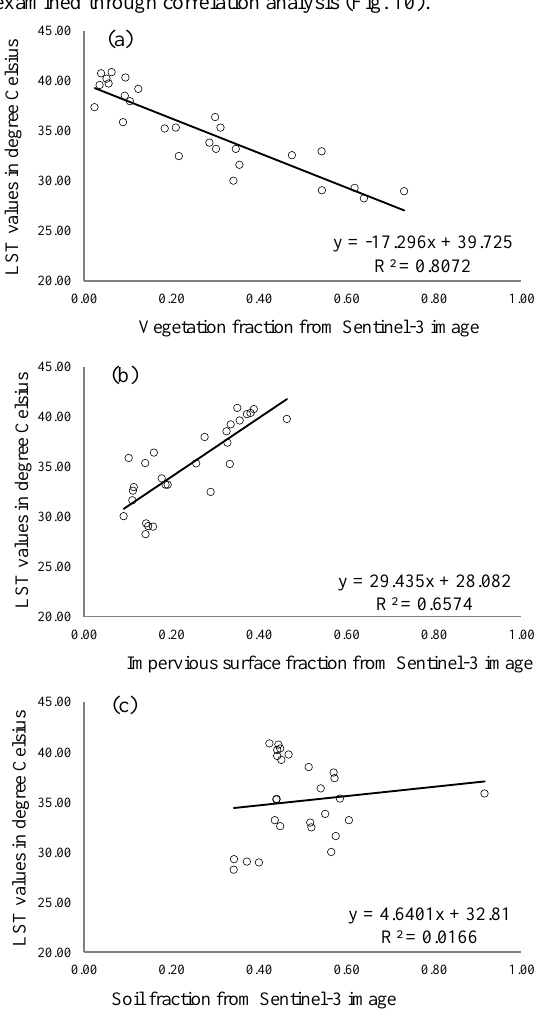
Figure 10. Relationships between LST and relative abundances of vegetation (a), impervious surfaces (b), and soil (c). Fraction images (x-axis) range from 0 to 1 while LST values (y-axis) are expressed in degree